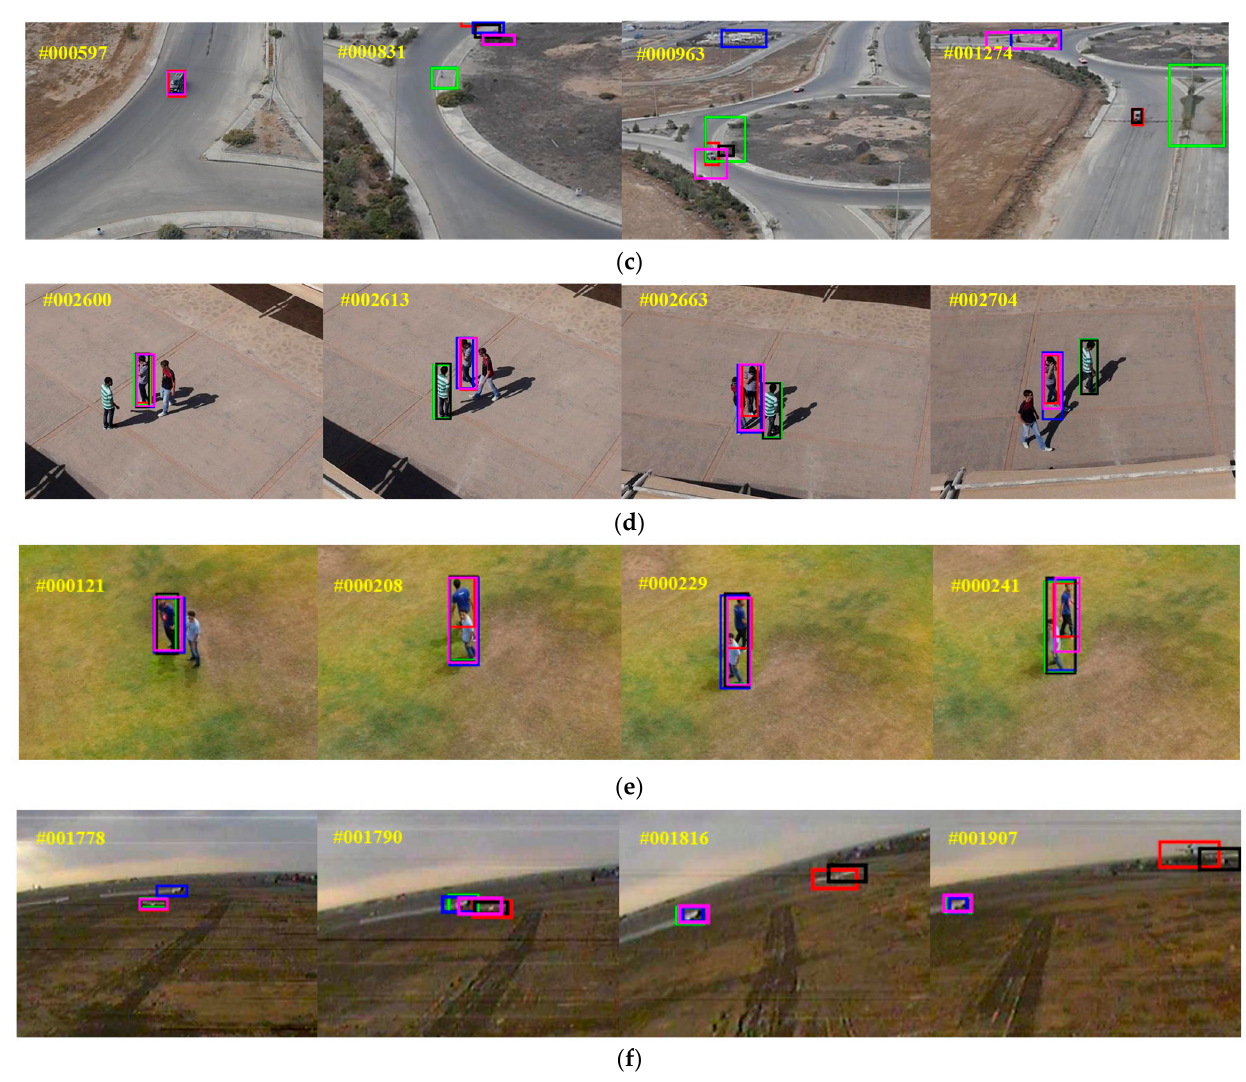
Figure 11. Case study of the proposed SiamHAS and several state-of-the-art trackers on the UAV123 dataset. From the top to bottom, the pictures show the visual case experiment results on the image sequences of ( a ) Bird1, ( b ) Car9, ( c ) Car14, ( d ) Group1, ( e ) Person11, and ( f ) Uav1. Red—Ours, Green—SiamCAR, Blue—SiamRPN++, Black—SiamRPN, Pink—SiamFC.